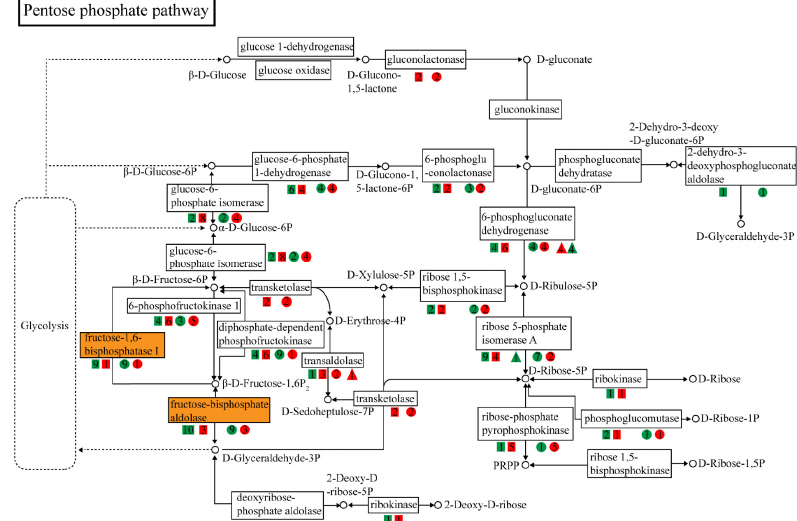
Figure A3. DEGs in pentose phosphate pathway. Squares represent DEGs based on the comparison between gall vs. LWG; circles represent DEGs based on the comparison between gall vs. LNG; triangles represent DEGs based on the comparison between LNG vs. LWG. Red color indicates up-regulation and green color indicates down-regulation. The numbers within shaded shapes indicate the number of genes. There were 48 genes up-regulated and 53 genes down-regulated based on the comparison between gall vs. LWG, 40 genes up-regulated and 44 genes down-regulated based on the comparison between gall vs. LNG, three genes up-regulated and three genes down-regulated based on the comparison between LNG vs. LWG. The genes encoding fructose-bisphosphate aldolase and fructose-1,6-bisphosphate I were down-regulated.